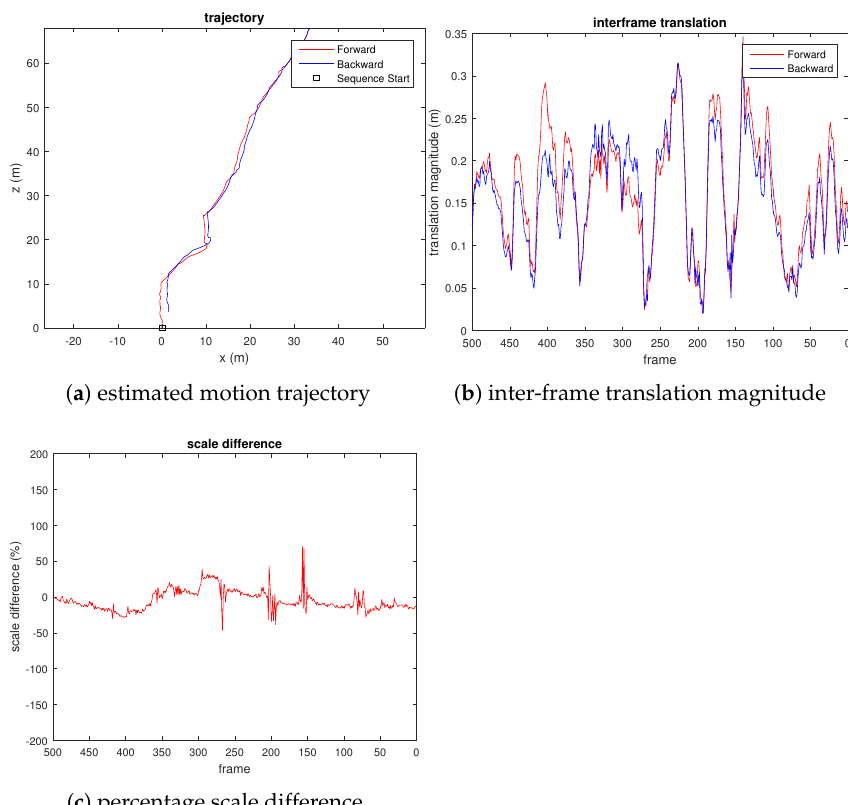
Figure 6. Plots evaluating the scale drift of our proposed visual odometry on UAV video, where percentage scale difference refers to the percentage error of the translation magnitude compared to the true translational